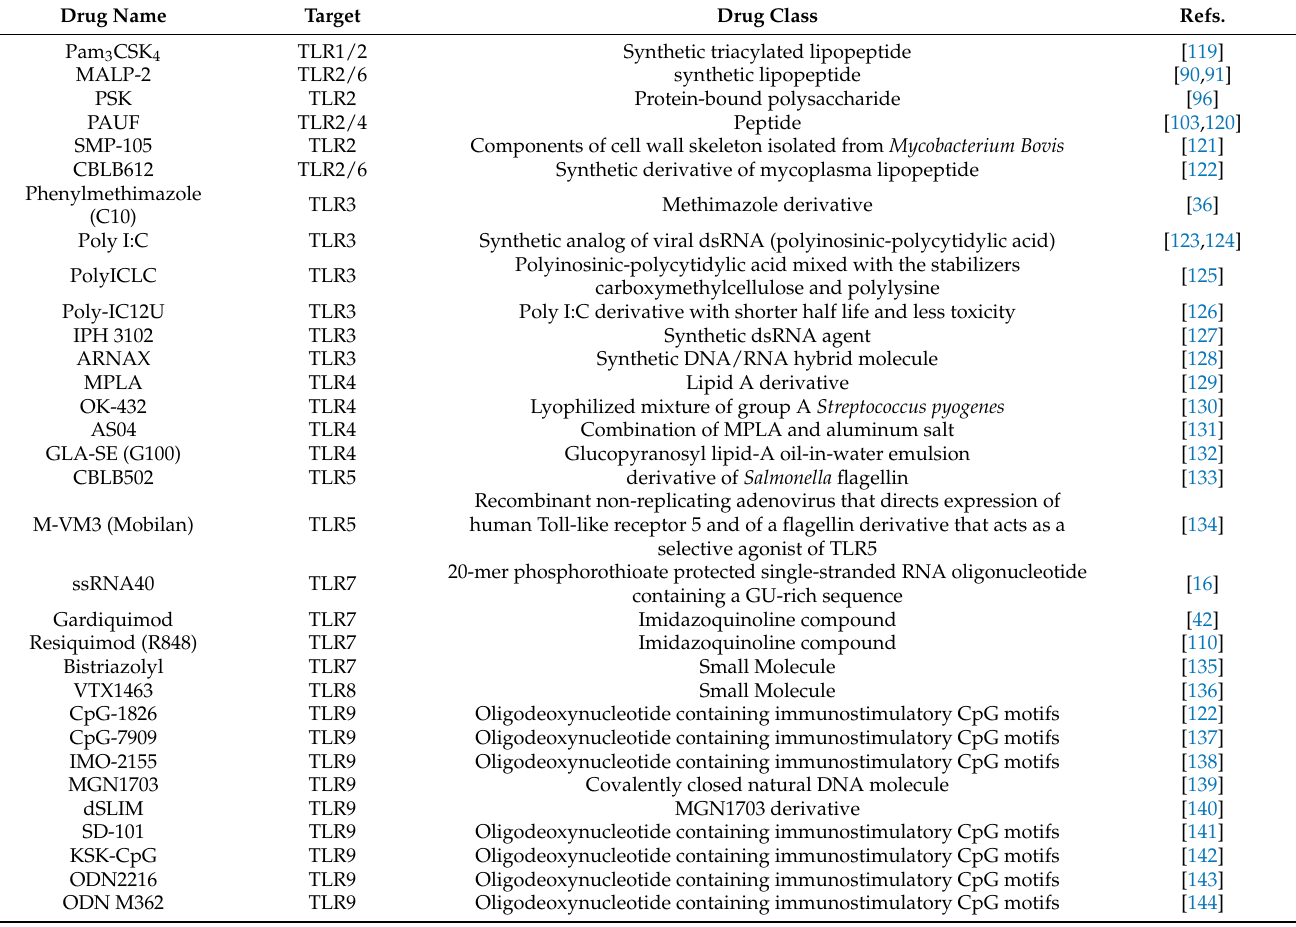
Table 3. List of agonists of Toll-like